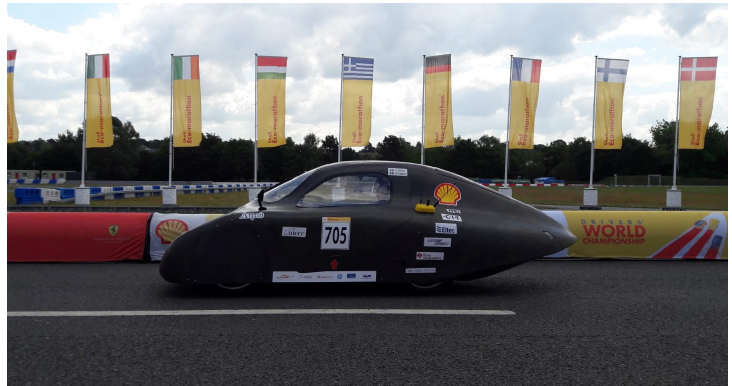
Figure 1. The urban concept vehicle “Leto” considered in this